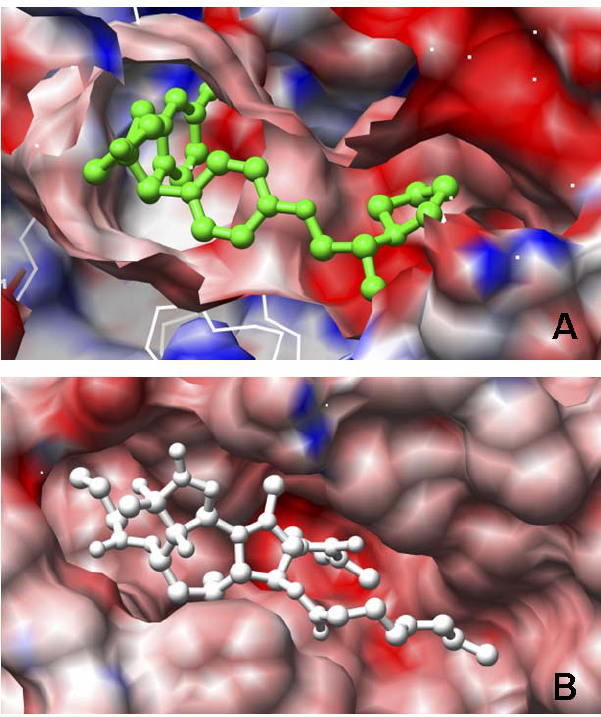
Figure 5. Electrostatic Potential (ES) of the Ligand Binding Site in: (A) the Original Drug Target ER a (PDB id: 1XPC), and (B) Predicated Off-Target SERCA (PDB id: 2AGV)